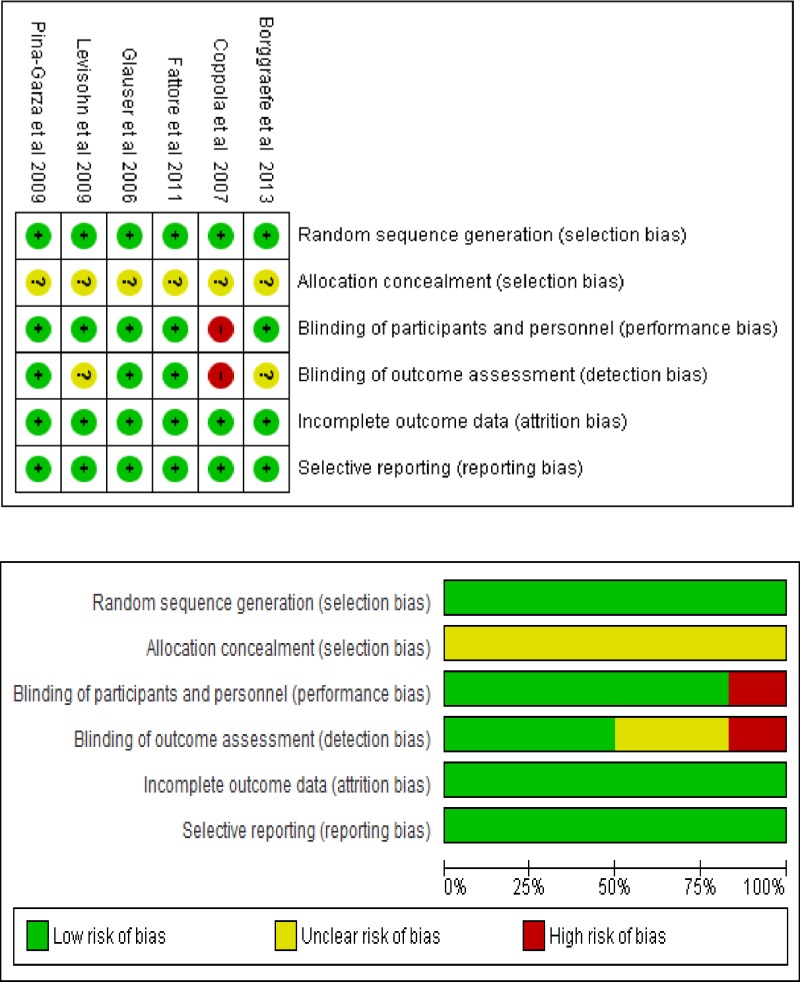
Risk of bias summary and graph.